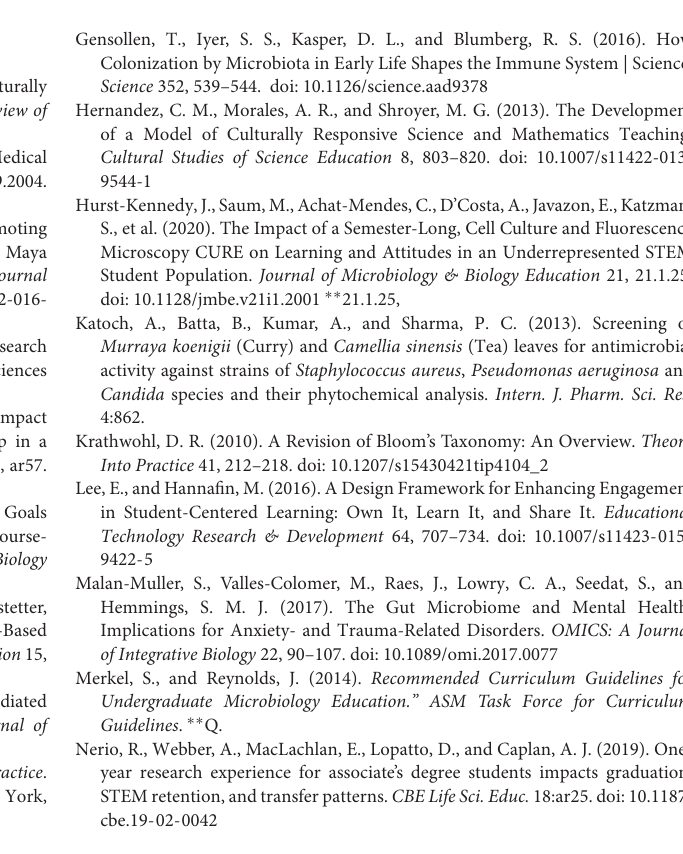
Supplementary Figure 1 | Sample student